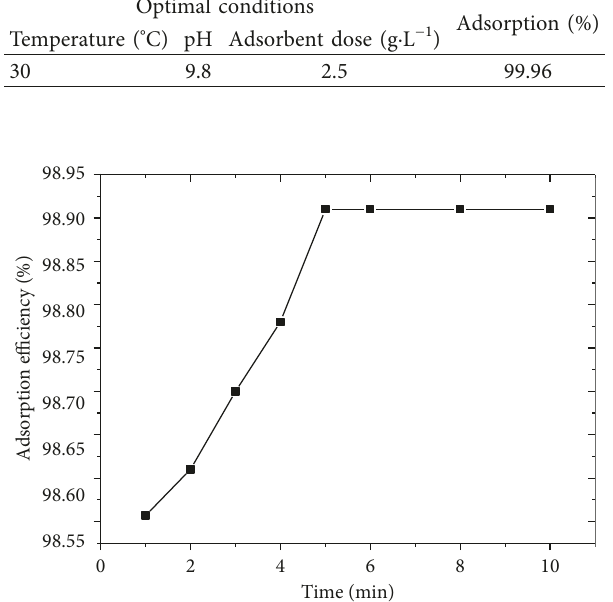
Table 7: Established optimal conditions. Optimal conditions